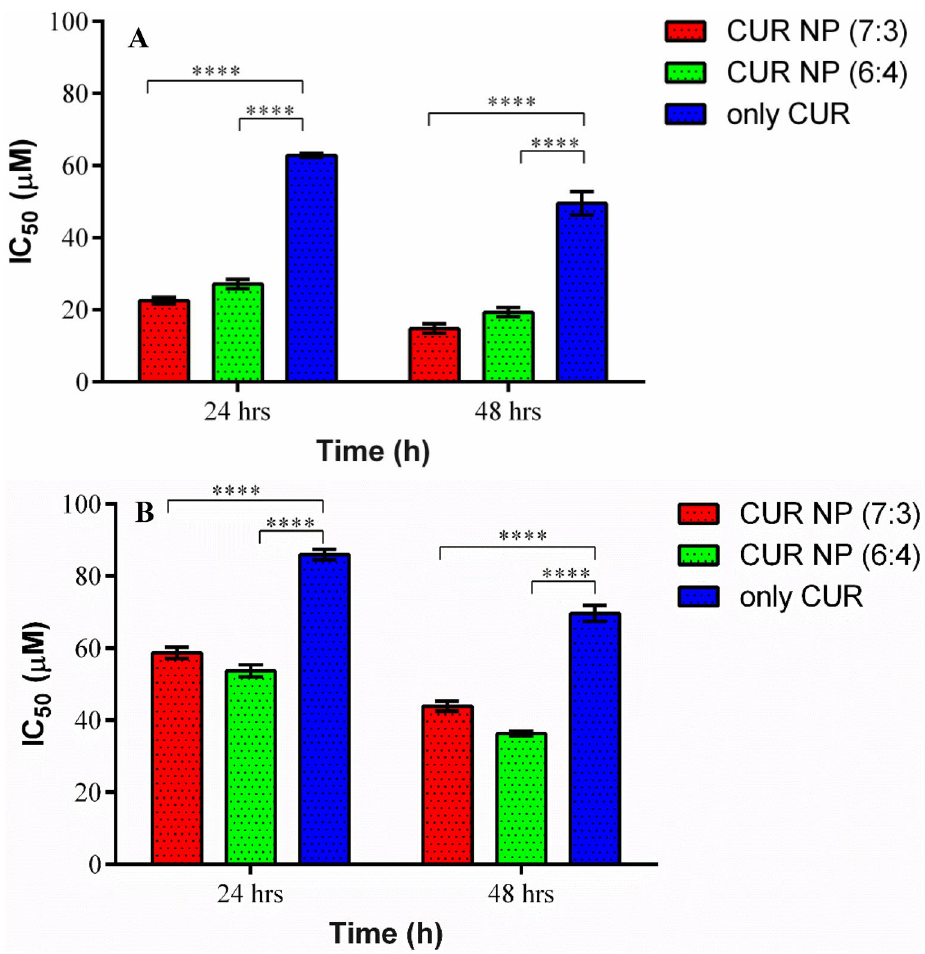
Figure 5. Represents IC 50 values of CUR NP (7:3), CUR NP (6:4) and CUR only at 24 h and 48 h on ( A ) MCF- 7, ( B ) MDA-MB-231 cell line. Statistical analysis was performed using multiple variance analysis (two way ANOVA) with Tukey’s test. (****p < 0.0001, ns not significant and n = 3).